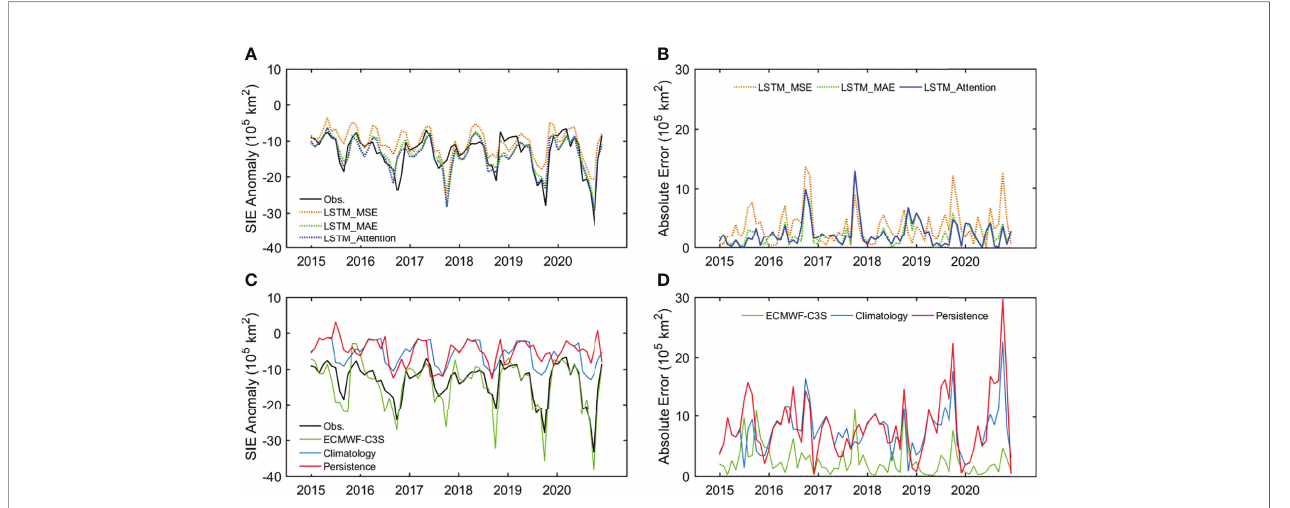
FIGURE 5 | Monthly Arctic SIE anomaly predicted by three LSTM models during January 2015 – December 2020, with the satellite observation as a reference (A) . Absolute errors of monthly SIE between forecasts from three LSTM models and the observation (B) . (C, D) are similar to (A, B) , but for sea ice forecasts from ECMWF-C3S, Climatology, and